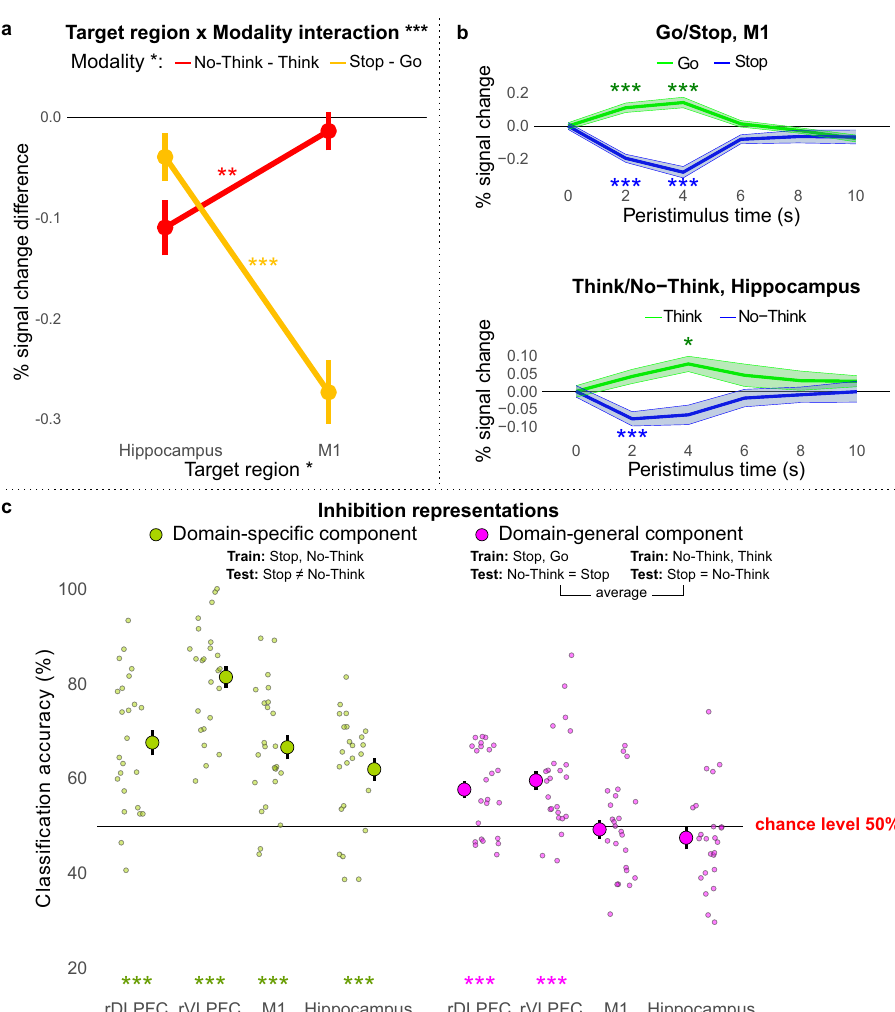
Fig. 5 ROI analysis of domain-speci fi c and domain-general modulation during thought and action suppression. a – c *** p < 0.001; ** p < 0.01; * p < 0.05. Data are presented as mean values. Error bars/shading represent within-subject standard error. Sample size n = 24. Source data are provided as a Source Data fi le. a Target areas M1 and hippocampus were modulated in a domain-speci fi c manner. We calculated the BOLD signal in each target ROI for each condition by averaging across the time points from 2 to 6 s post-stimulus onset and subtracting out the onset value to account for pretrial variability. Then